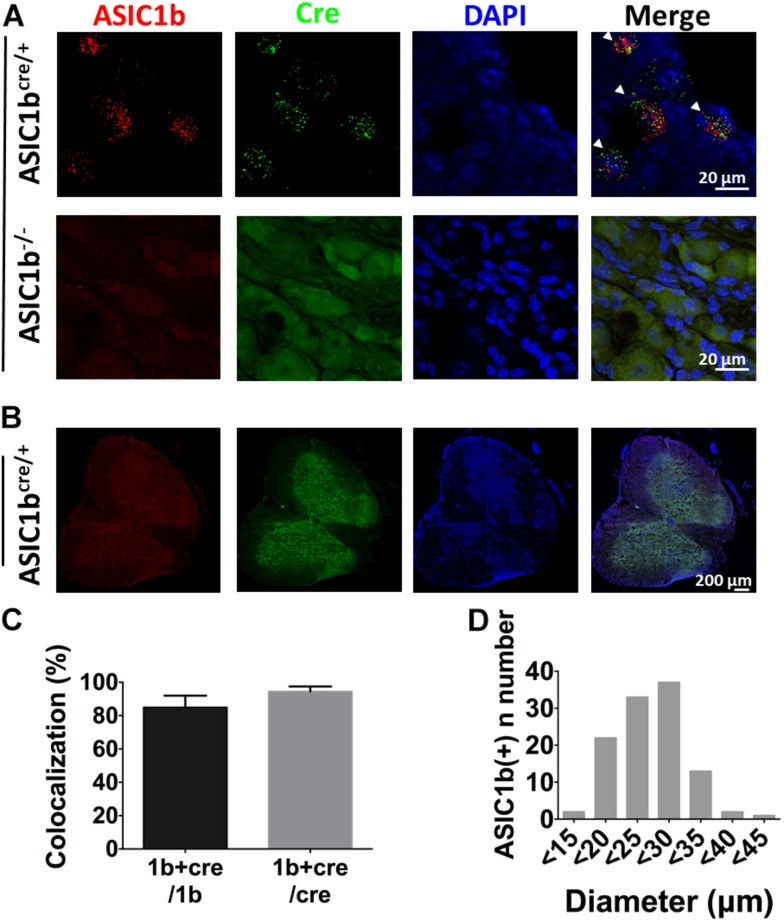
Validation of Asic1b-Cre and Asic1b-knockout mice by in situ hybridization. (A) Duplex hybridization of ASIC1b and Cre transcripts in L4 DRG neurons of Asic1bCre/+ (arrowheads) and Asic1b– /– mice. (B) Lack of ASIC1b and Cre transcripts in the spinal cord of Asic1bCre/+ mice. (C) Quantitative analysis of Asic1b and Cre co-localization in Asic1bCre/+ DRG neurons (N = 3 mice). Data are mean ± SEM. (D) Histogram of ASIC1b-expressing DRG neurons by size.